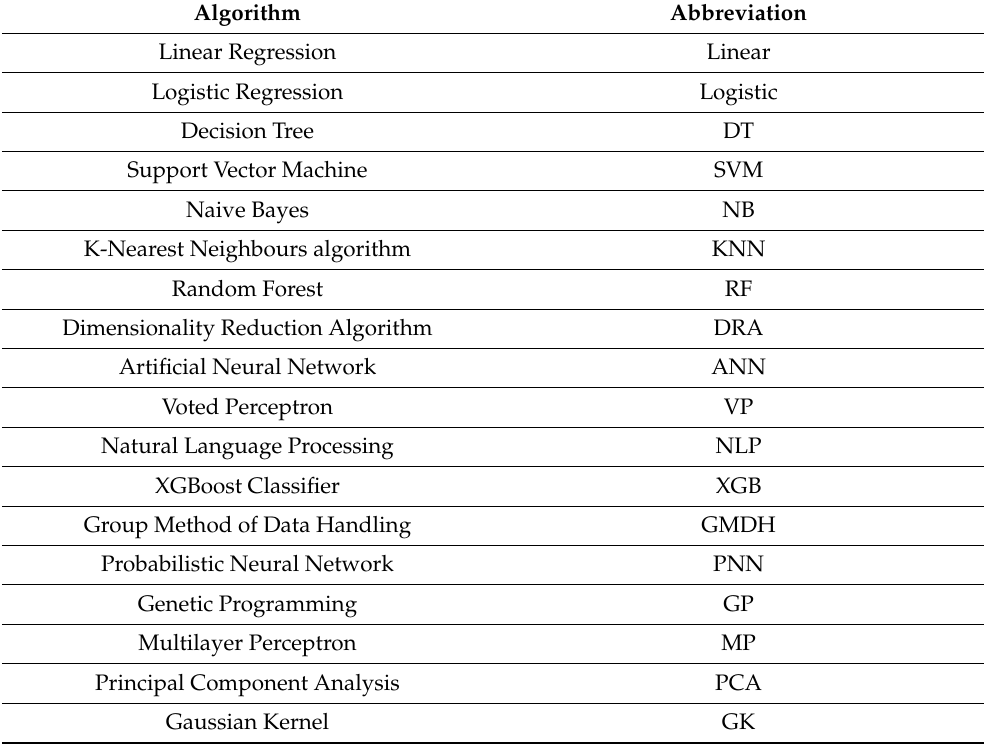
Table 4. List of algorithms used in the literature and their